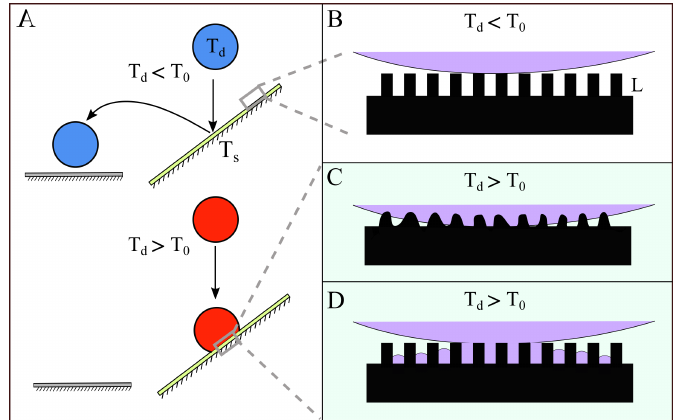
Figure 1. A schematic illustrating how a thermally responsive superhydrophobic material could act as a fuse to prevent water above a critical temperature from reaching a sensitive surface. ( A ) If the superhydrophobic surface that is at T s rapidly pinned drops above a critical temperature T 0 , then a water drop with temperature T d below T 0 (top) would bounce off of the surface onto the target, whereas a water drop with temperature T d above T 0 (bottom) would stick, protecting the target; ( B ) surface microtexture with lengthscale L can trap air beneath the drop (Cassie–Baxter state), enabling the drop to bounce; ( C ) If heat from the drop melts the microstructure, the drop could enter a Wenzel state and stick; ( D ) Alternatively, if liquid from the drop evaporates and condenses within the microstructure, the drop could also enter a Wenzel state and